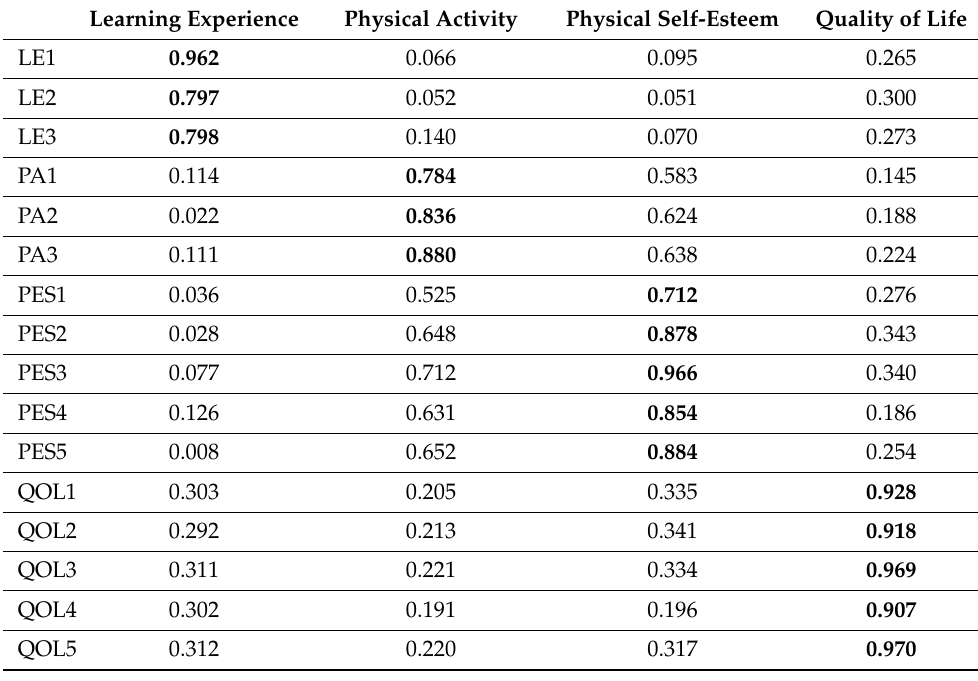
Table 3. Cross-loading for study factors.